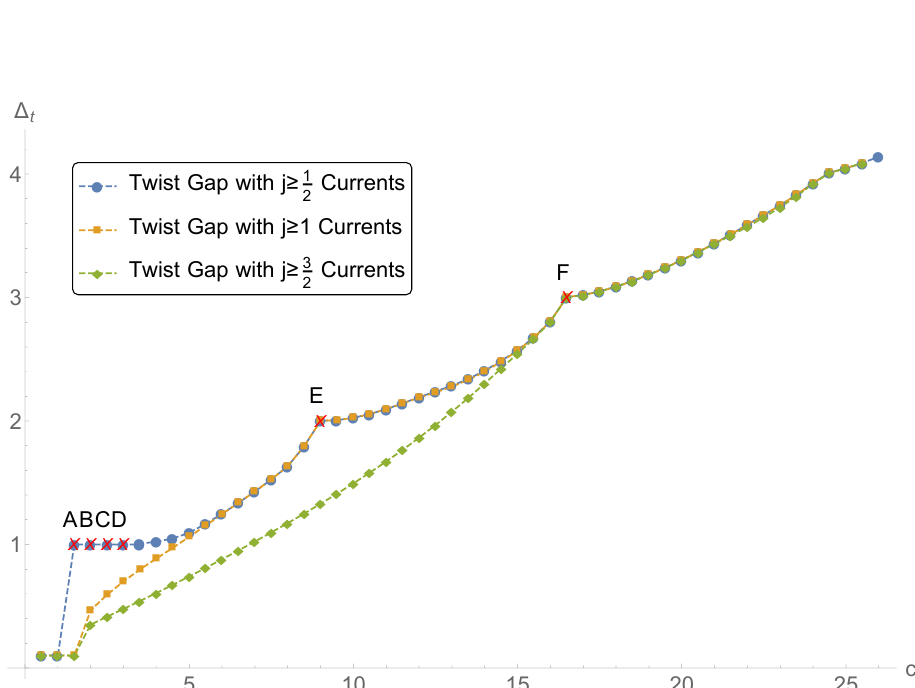
Figure 6 . Numerical upper bounds on the twist gap for the N = 1 SCFTs with imposing the conserved currents of j (cid:21) 1